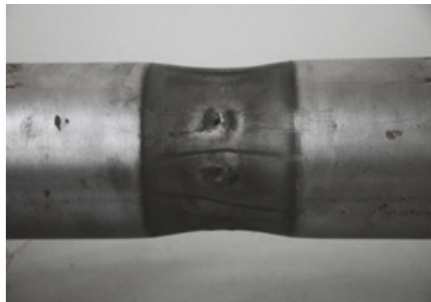
Figure 5: State of the tube after